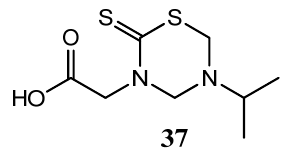
Figure 13. THTT derivative of glycine with antifungal activity.